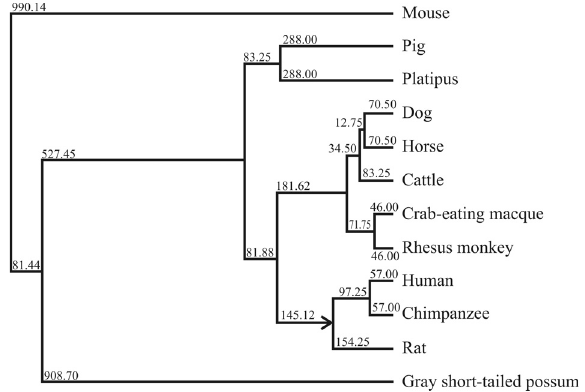
Figure 5 - The phylogenetic tree for twelve kinds of PBK genes.